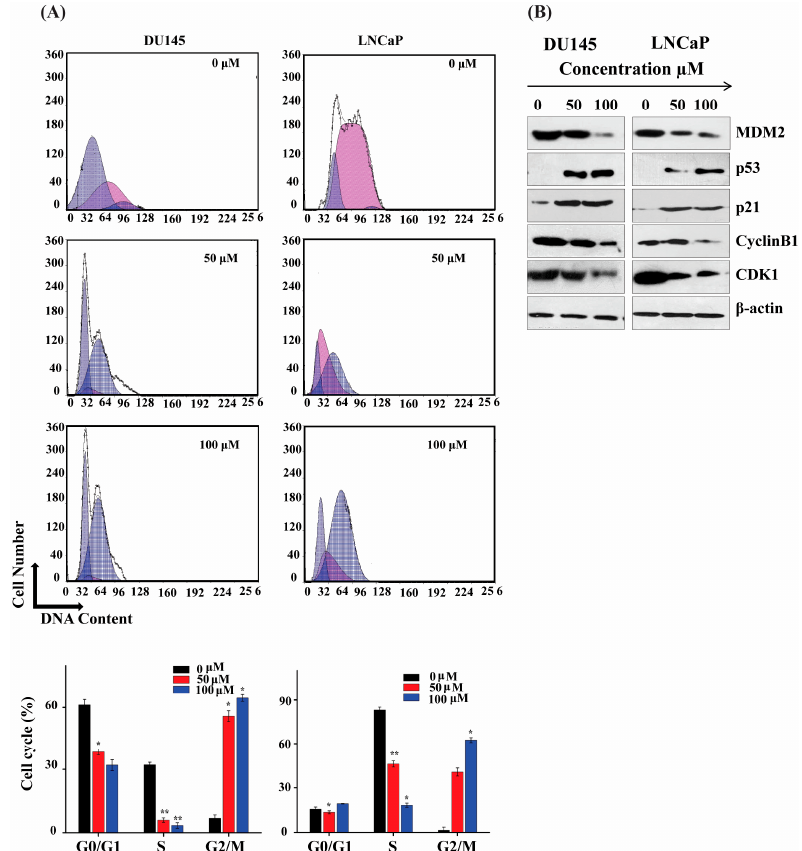
Figure 2. ATR II induce prostate cancer cell cycle arrest at the G2/M phase. ( A ) DU145 and LNCaP cells were treated with ATR II (0, 50 and 100 µM) for 48 h, and stained with PI for flow cytometric analysis. Histograms show a number of cells/channel (y-axis) vs. DNA content (x-axis). The values indicate the percentage of cells in the indicated phases of the cell cycle. The data are shown the representative of three independent experiments with similar results. * p < 0.05; and ** p < 0.01 compared with the control. ( B ) DU145 and LNCaP cells were treated with ATR II (0, 50 and 100 µM) for 48 h, then cellular proteins were extracted and the level of protein 53 (p53), p21 cyclin B1, cyclin depend kinase 1 (CDK1), Mouse double minute 2 (MDM2) as well as β -actin (control) were detected by western blotting.